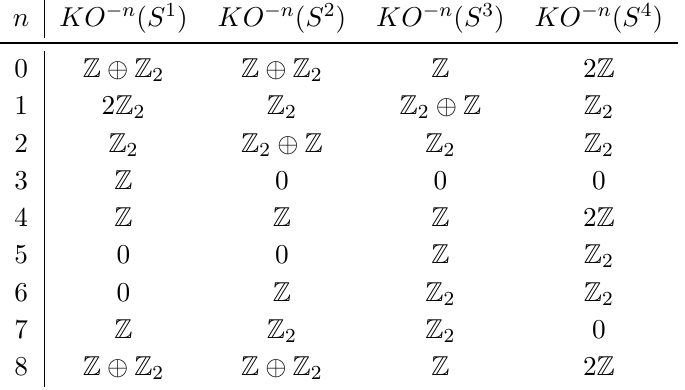
Table 27 . KO-groups of spheres KO − n ( S k ) , k = 1 , . . . , 4 .